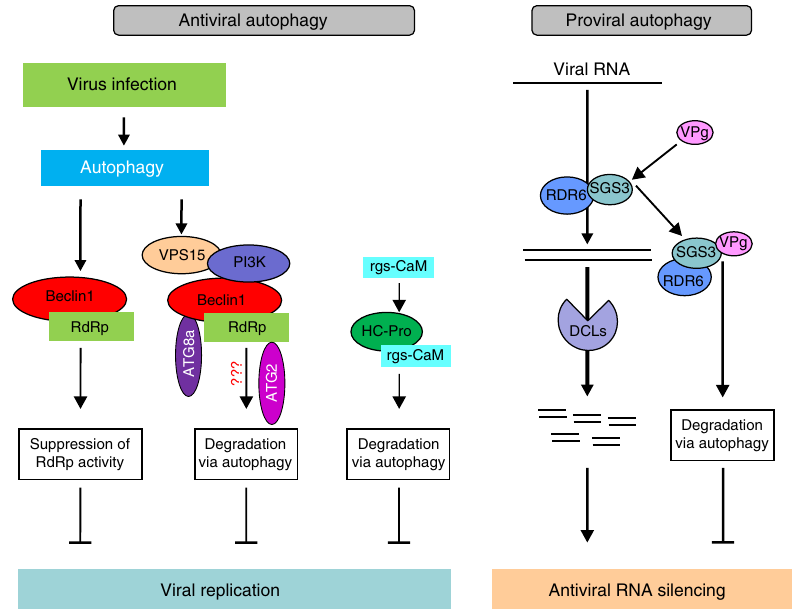
Fig. 10 Proposed model for the possible roles of autophagy in the potyviral infection. Infection by positive-sense RNA viruses activates autophagy in plant cells. Beclin1 (ATG6) binds to the GDD motif of the viral RNA-dependent RNA polymerase (RdRp) to inhibit virus replication, which is independent of the autophagy pathway. Beclin1 may also serve as a cargo receptor to interact with the viral RdRp and target the RdRP-containing virus replication complex via the interaction of Beclin1 with other autophagy proteins (e.g., ATG8a) to autophagosomes for degradation. The mechanic details leading to the autophagy- mediated degradation remain to be fully understood. Simultaneously, HC-Pro, a virulence factor and the major potyviral VSR, is hijacked by host rgs-CaM to induce its degradation by the autophagy pathway 56 . Meanwhile, the second potyviral VSR, VPg, mediates the degradation of RNA silencing components SGS3 and RDR6 via the autophagy pathway to suppress antiviral RNA silencing